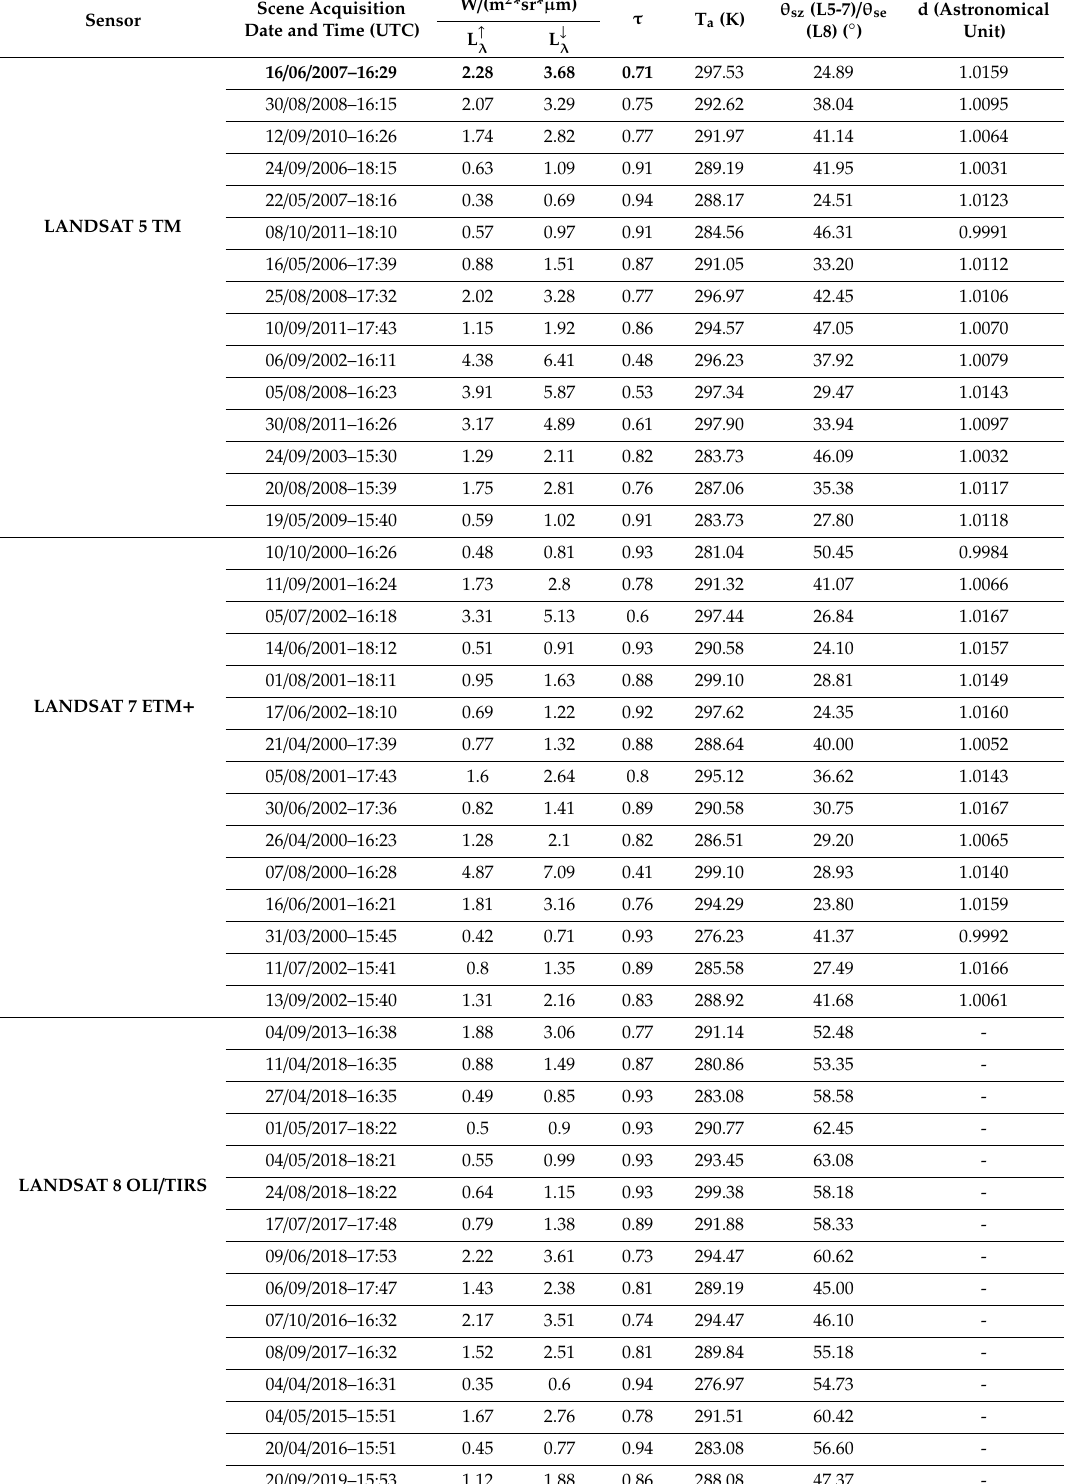
Table A6. Estimated atmospheric and model parameters used in this study for LST methods. Scene Acquisition Sensor Date and Time